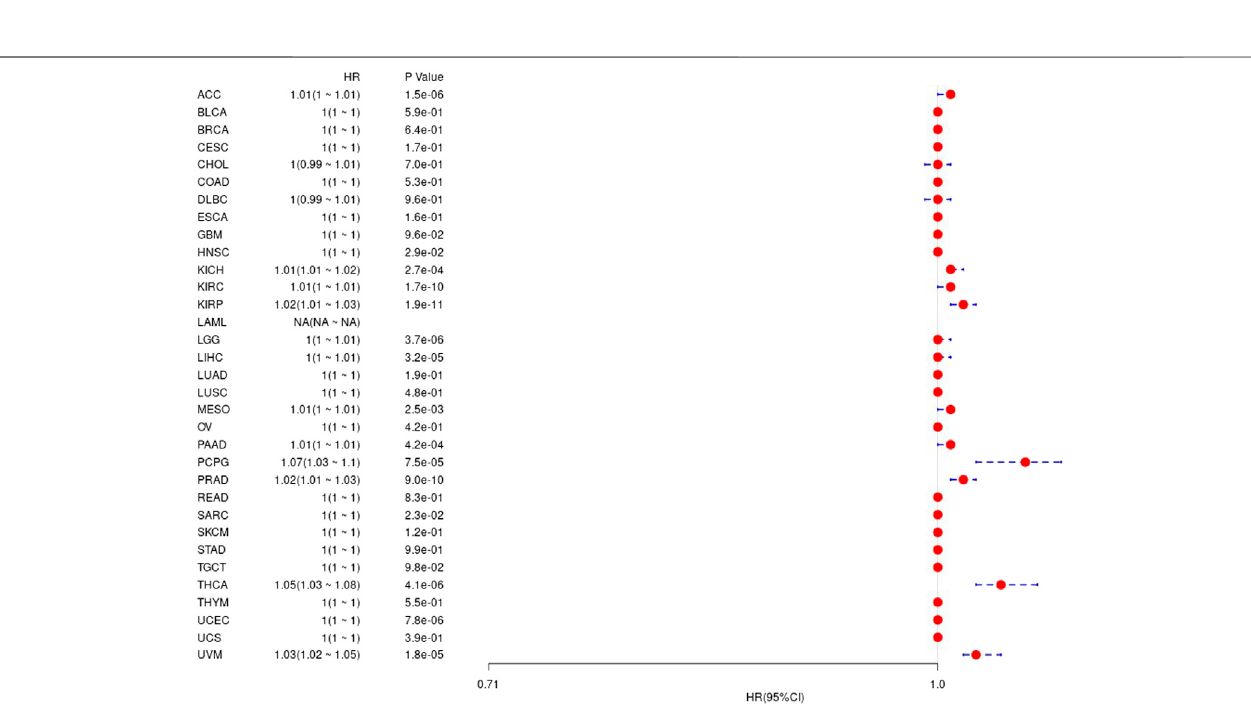
FIGURE 6 | The relationship between UBE2C gene and disease-free interval in TCGA tumor and nontumor.